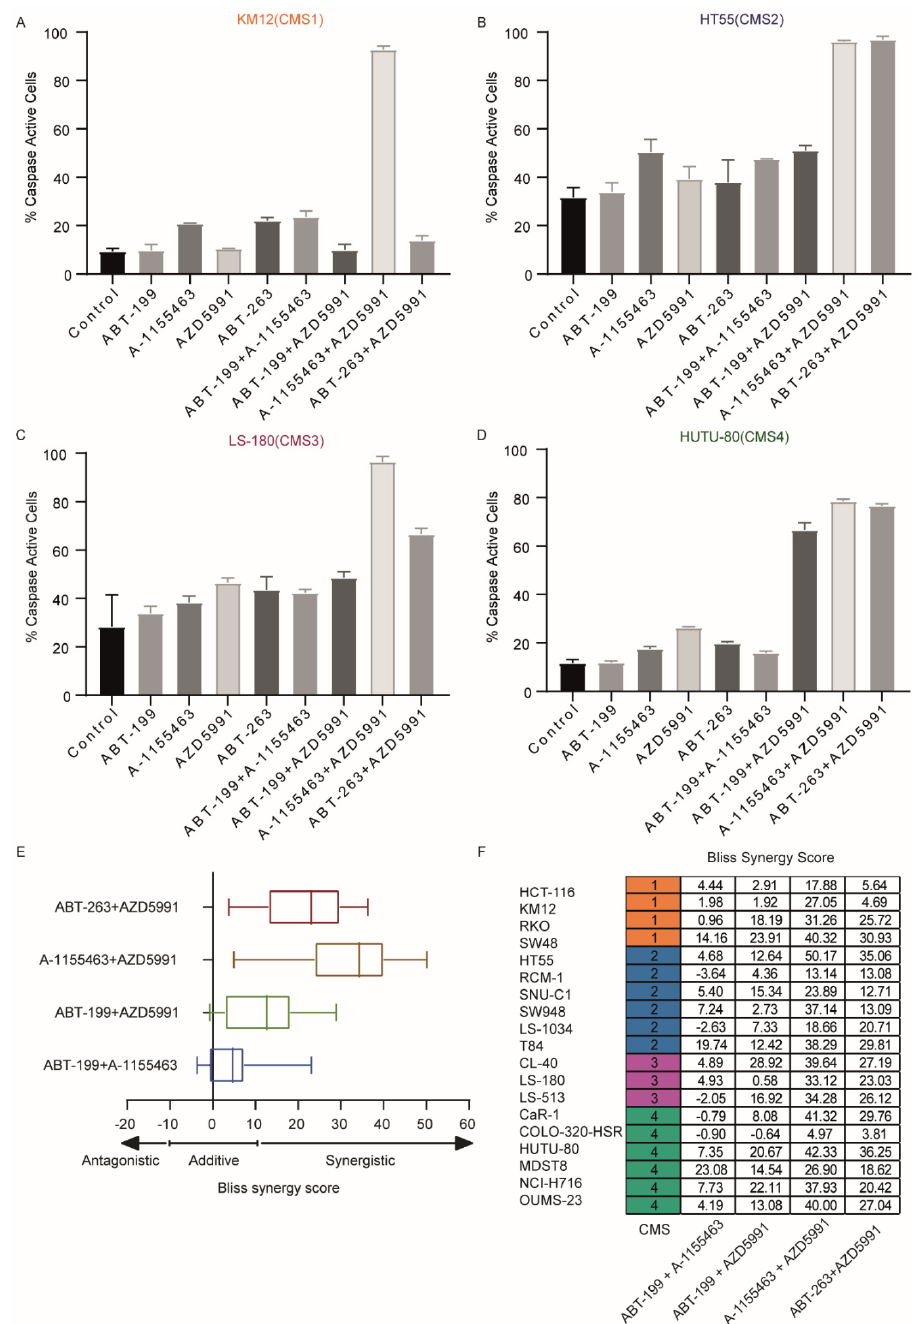
Figure 2. Synergy between different BH3 mimetics in CRC cells. ( A – D ) Flow cytometry analysis of the activation of caspase-3 induced by different BH3 mimetics and combinations in four representative CRC lines; ( E , F ) bliss synergy score of the four combinations for all CRC cell lines. Scores below -10 are considered antagonistic, while scores between -10 and 10 are considered additive. Scores above 10 are considered synergistic.